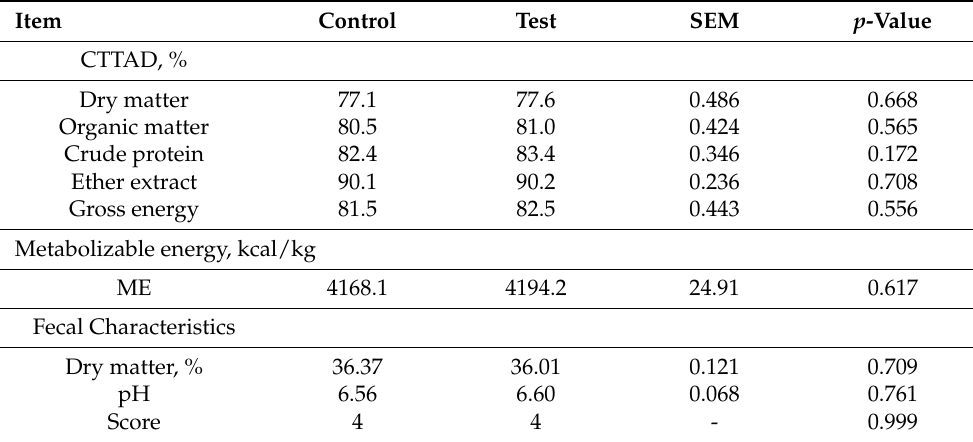
Table 2. Means of coefficients of total tract apparent digestibility (CTTAD, %), metabolizable energy, and fecal characteristics of dogs fed diets containing choline chloride (control) or the herbal source of choline (test).